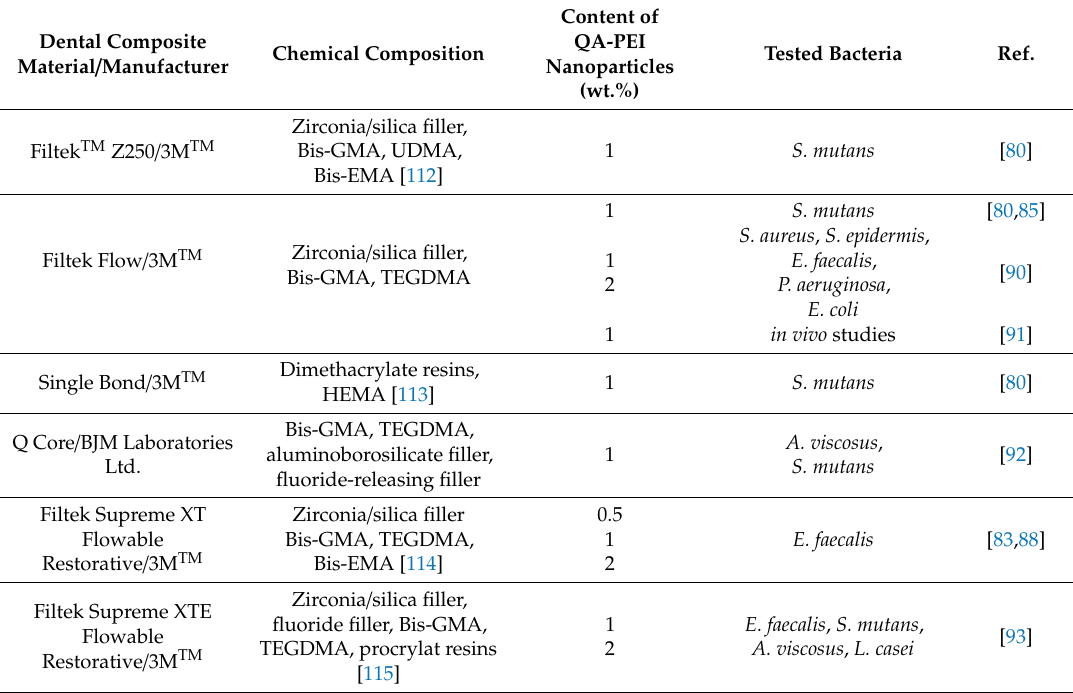
Table 3. Commercially-available dental composite materials tested for antibacterial activity after modification with QA-PEI